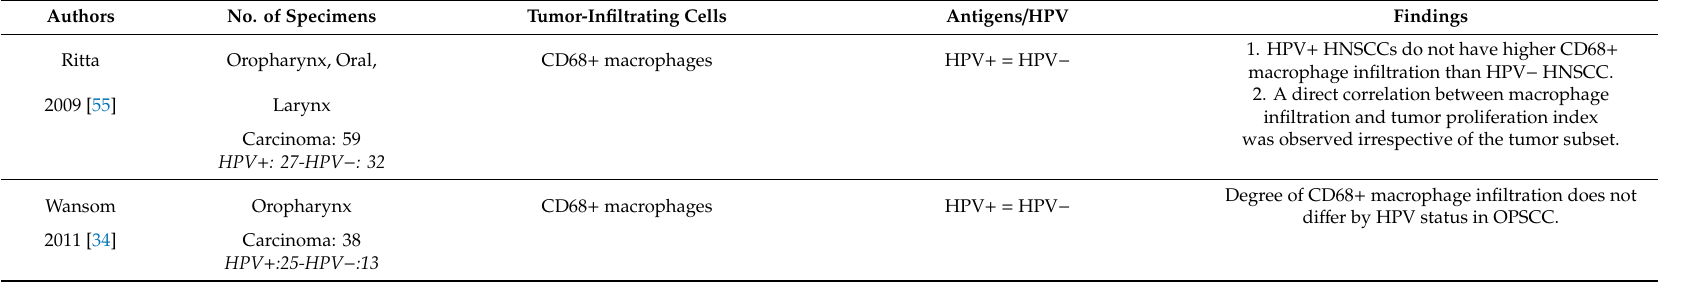
Table 5. Macrophage infiltration in HNSCC according to HPV